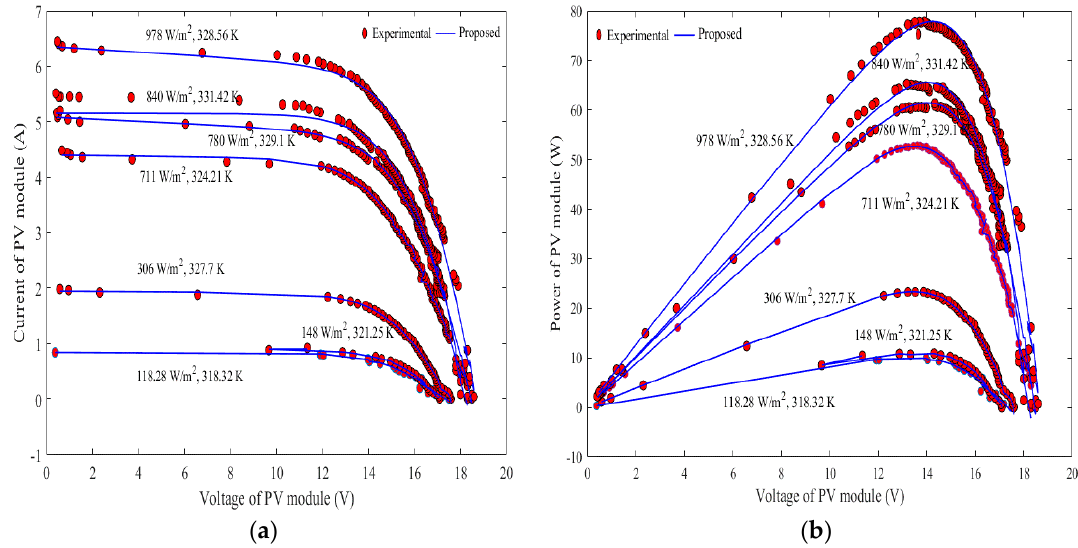
Figure 3. Photovoltaic (PV) characteristics under various cell temperature and solar radiation of improved electromagnetism (IEM) algorithm ( a ) (I-V) curves and ( b ) (P-V) characteristics curves.